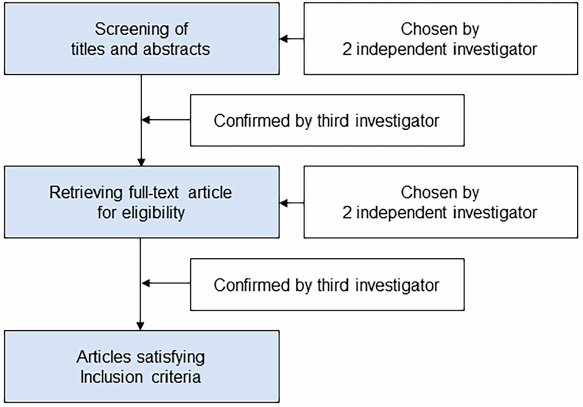
Figure 1. Schematic flow diagram of the study selection.